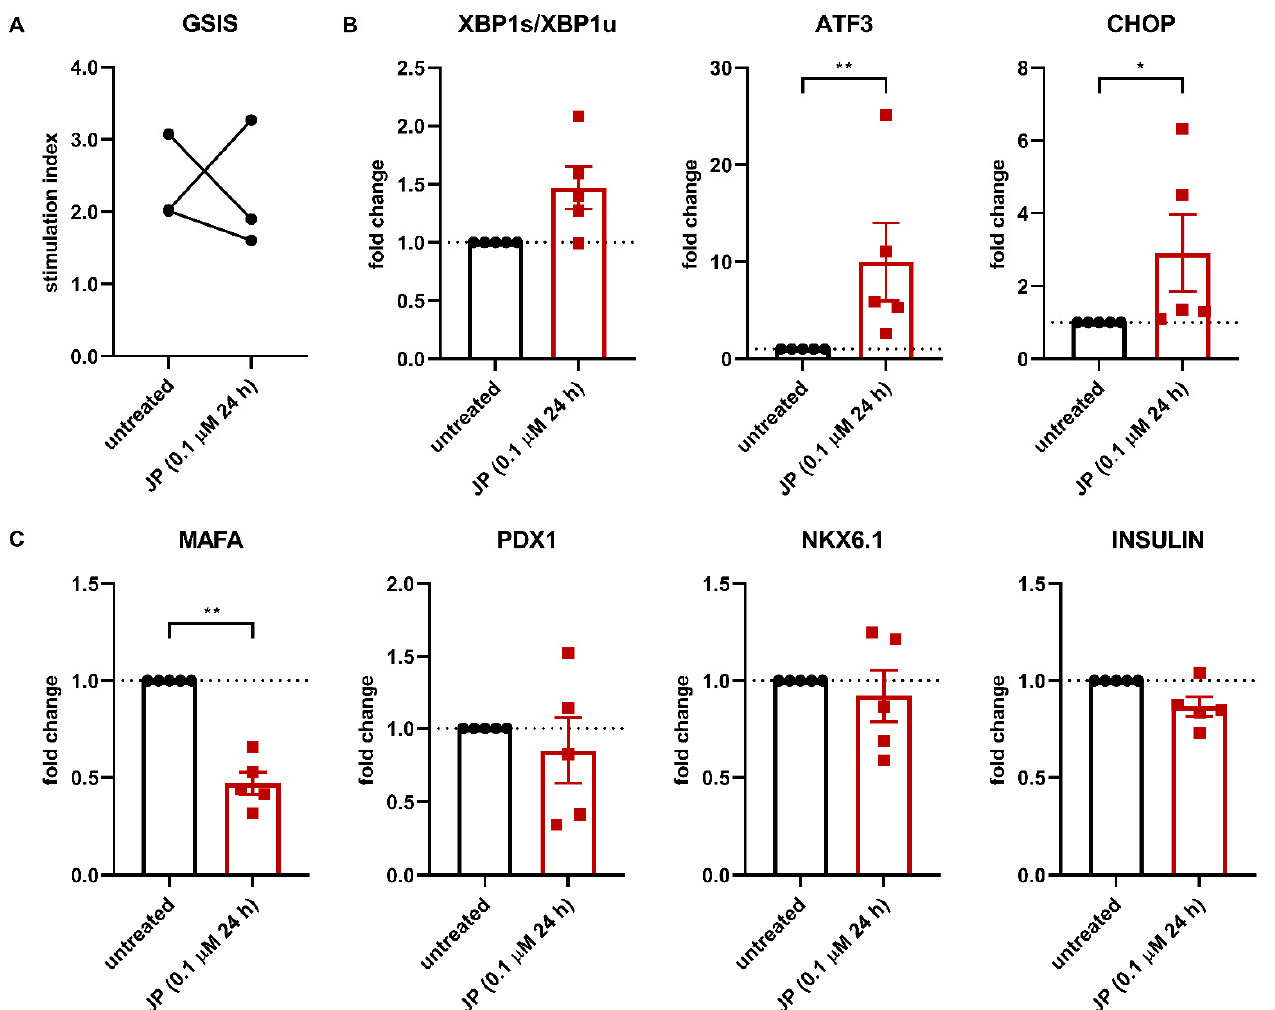
Figure 4. Altering the actin cytoskeleton triggers ER stress and affects β -cell identity and function. ( A ) Islet integrity disruption is further studied by altering the actin cytoskeleton using jasplakinolide (JP). Affecting the actin cytoskeleton in human islets with 0.1 µ M JP for 24 h leads to decreased glucose-stimulated insulin secretion in two of three donors. GSIS was performed immediately after 24 h JP treatment. ( B ) Treatment of isolated human islets with 0.1 µ M JP for 24 h leads to increased mRNA expression levels of the ER stress marker genes ATF3 and CHOP. ( C ) Treatment of isolated human islets with 0.1 µ M JP for 24 h leads to decreased mRNA expression levels of the β -cell-specific gene MAFA but not PDX1, NKX6.1 and insulin as measured by qPCR. Data are presented as means ± SEM of fold change over untreated control islets. n = 5 donors; each data point represents one donor. * p < 0.05, ** p < 0.01 vs. untreated control islets.